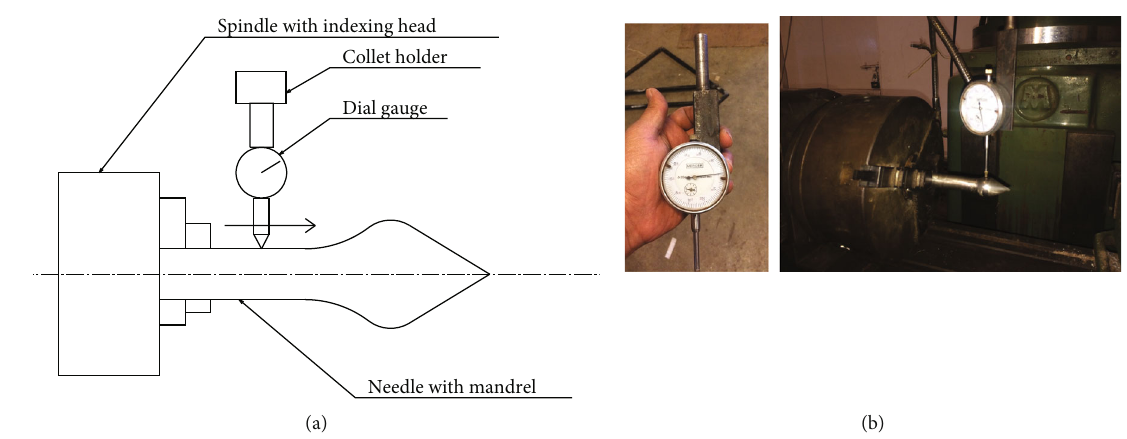
Figure 5: Measurement setup schematic on (a) and snapshot of pro fi le measurement with dial gauge fi xture on (b).